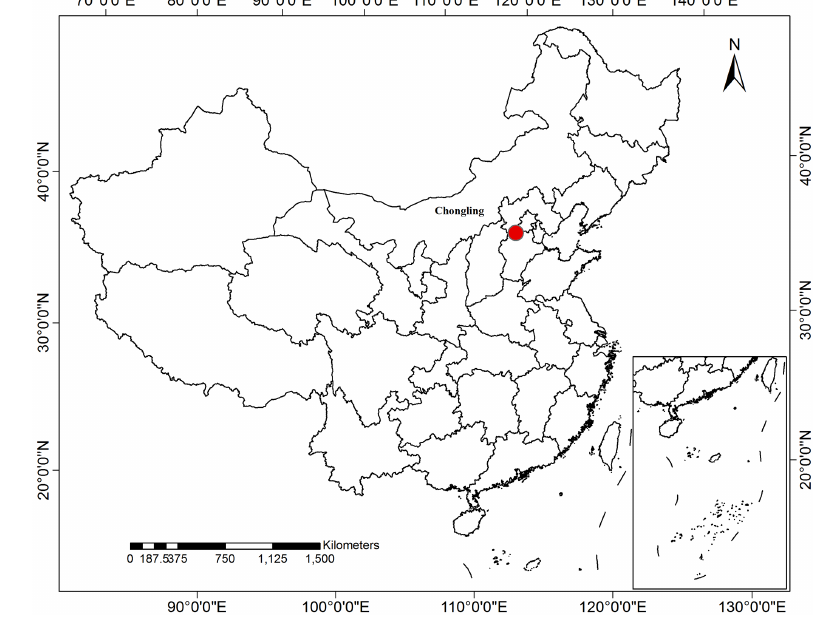
Figure 1. The study area: the Chongling Basin in China.